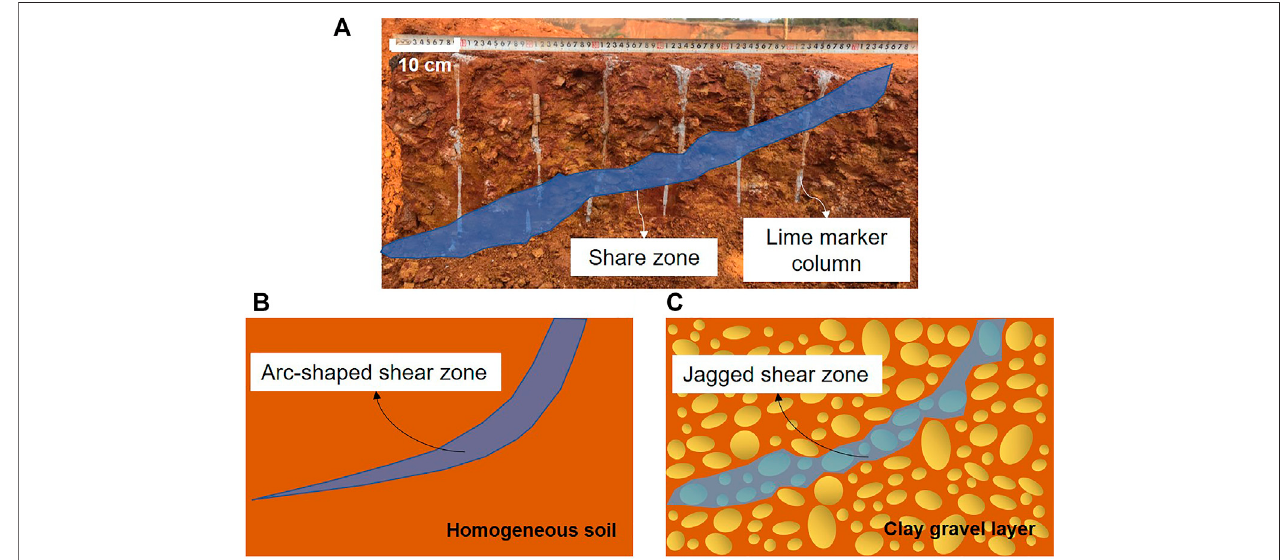
FIGURE 5 | Two-dimensional shape of shear zone in clay gravel layer (A) Sample C (B) Sample D (C) Sample E (D) Sample F.